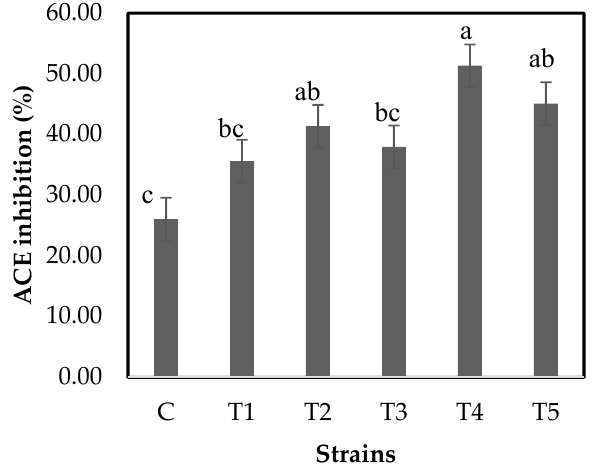
Figure 4. ACE inhibitory activity of the water-soluble extracts (WSEs) from yogurt. ABT-B, control yogurt without probiotics; T1, L. rhamnosus GG KCTC 12202BP; T2, L. plantarum KU15003; T3, L. plantarum KU15031; T4, L. plantarum NK181; T5, L. delbrueckii KU200171. Means from different yogurt expressed by lowercase letters (a–c) are significantly different ( p < 0.05).